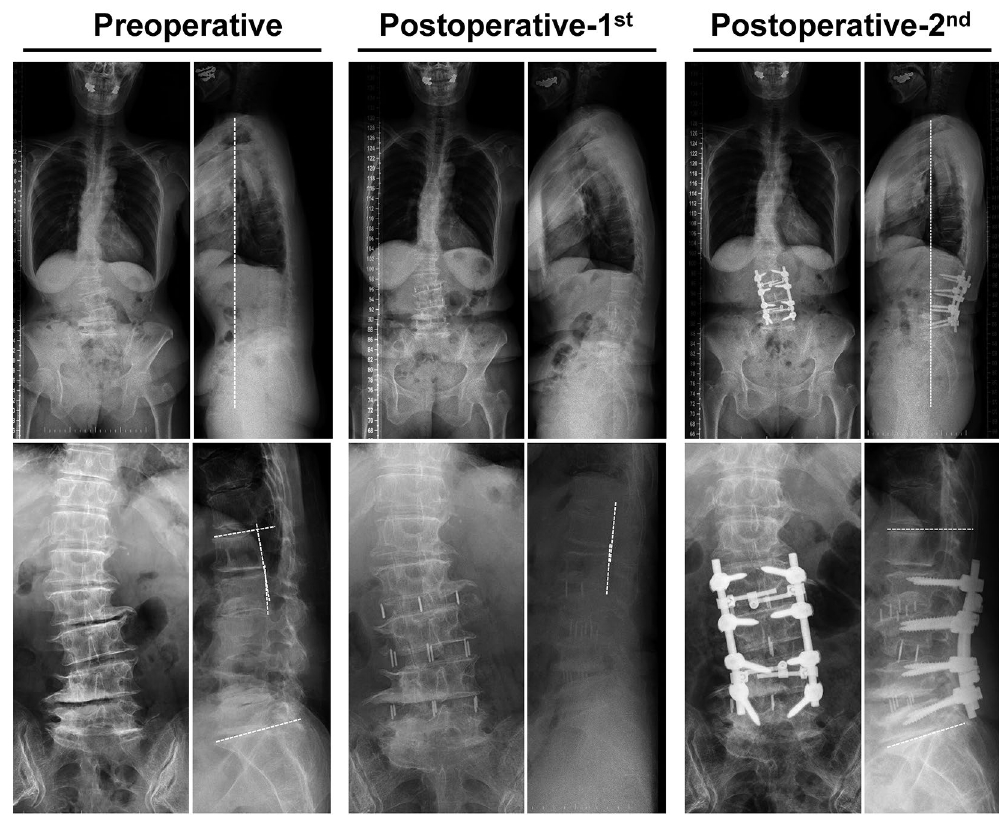
Figure 2. A 78-year-old female with severe low back pain and gait disturbance. Preoperative radiological parameters showed poor global alignment with C7 SVA 80.4 mm, LL −2.7°, L1–L2 angle −4.1°, and PI-LL 40.3°. The L1–L2 angle was 1.4° after the 1st operation. There were improvements to C7 SVA 25.9 mm, LL 19.6°, and PI-LL 21.9° at 2 years after